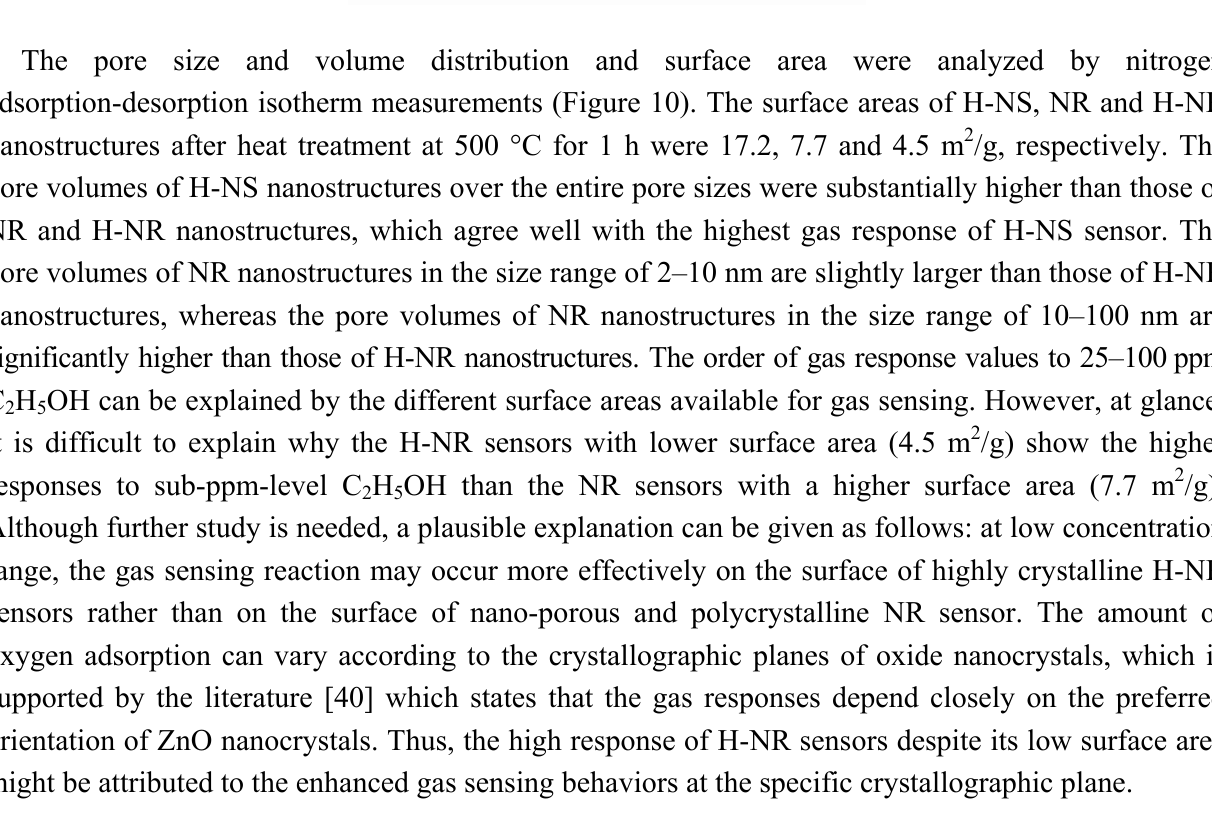
Figure 9. Gas responses to 0.2–100 ppm C